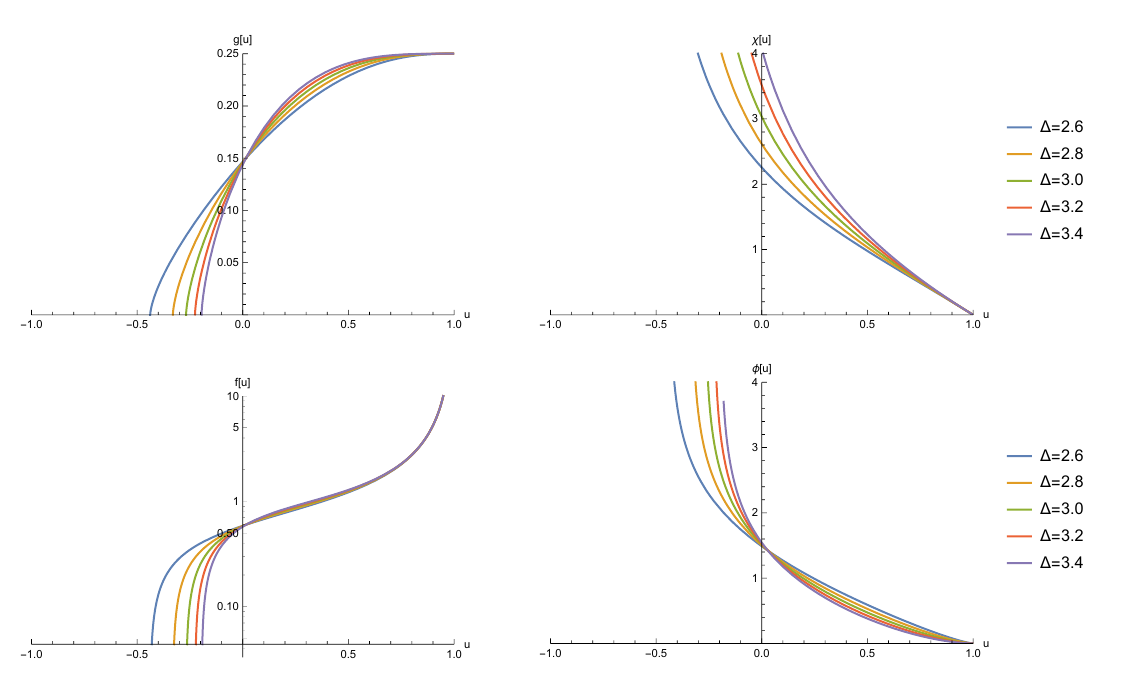
Figure 9 . Massive singular solutions for d = 3 with α = 4 . 0 .